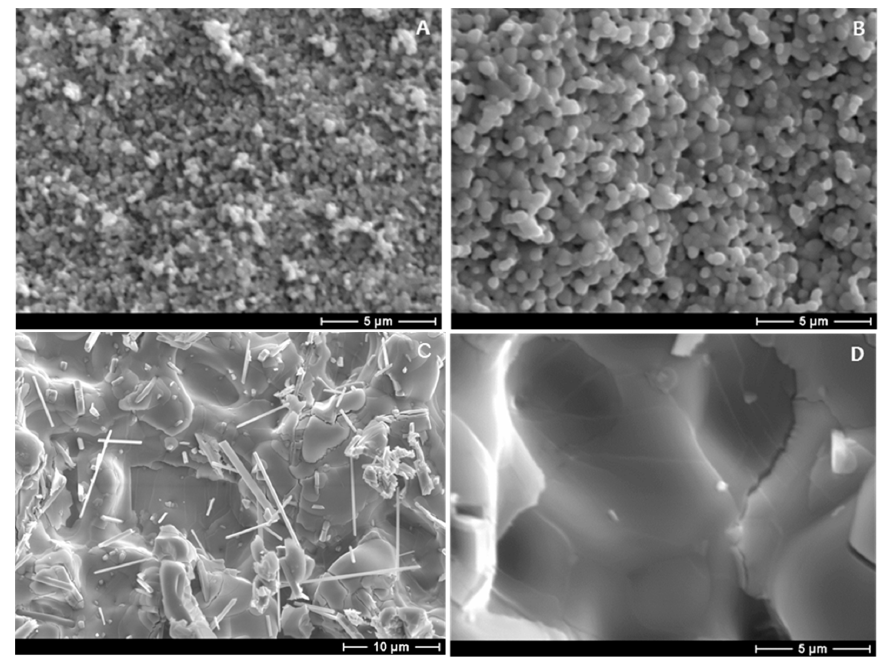
Figure 4. ( A ) 8YSZ with 10 mol.% MoO 2 . ( B ) Ni(NO 3 ) 2 infiltrated 8YSZ with 1 mol.% MoO 2 . ( C ) Ni(NO 3 ) 2 infiltrated 8YSZ with 5 mol.% MoO 2 . ( D ) Ni(NO 3 ) 2 infiltrated 8YSZ with 10 mol.% MoO 2 ,